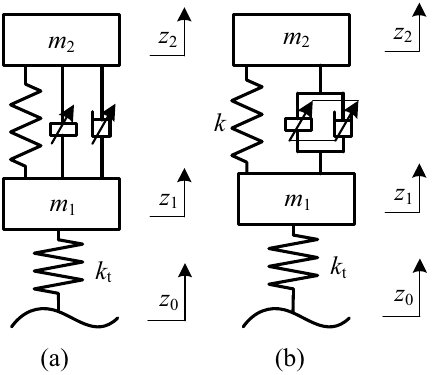
Figure 3. Two semi-active implementations of the multi-hook control systems: ( a ) semi-active suspension with an adjustable inerter and an adjustable damper; ( b ) semi-active suspension with a semi-active device of combining an adjustable inerter and